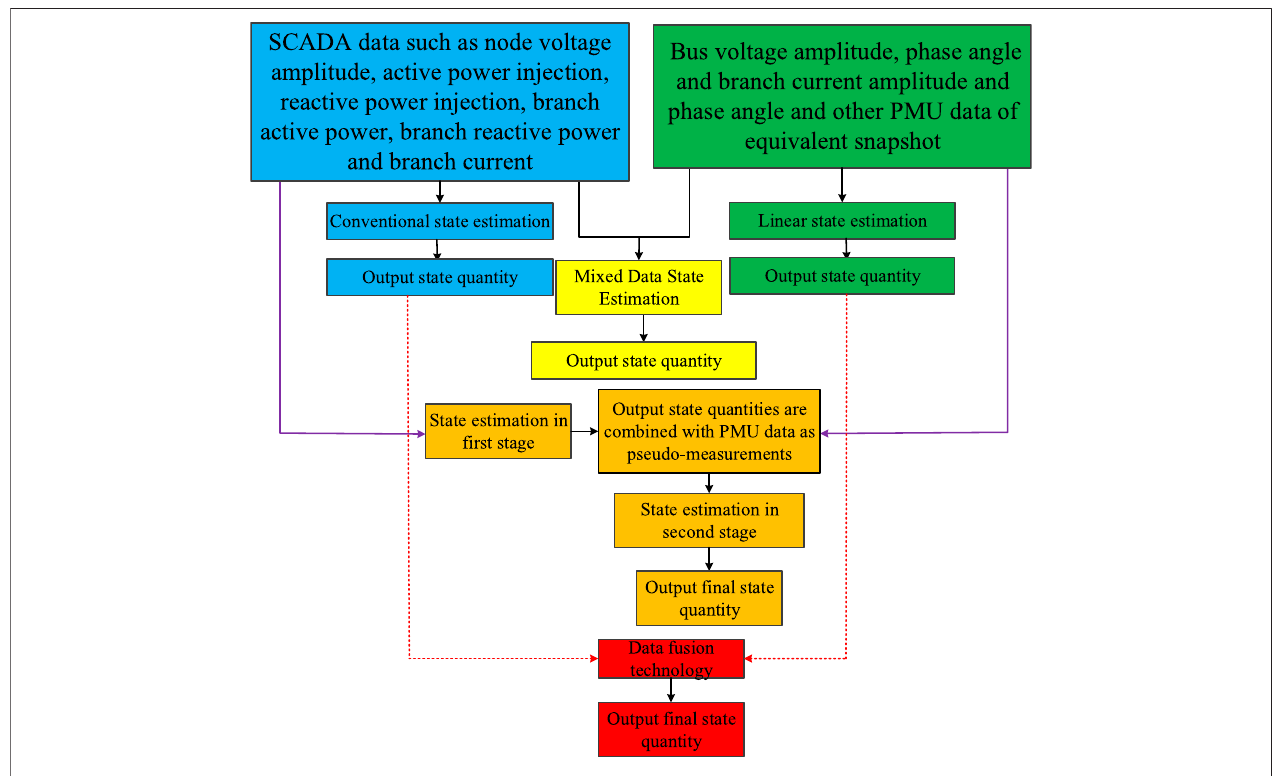
FIGURE 5 | The algorithm relationship diagram between the method proposed in this article and the HWLS and TWLS methods.